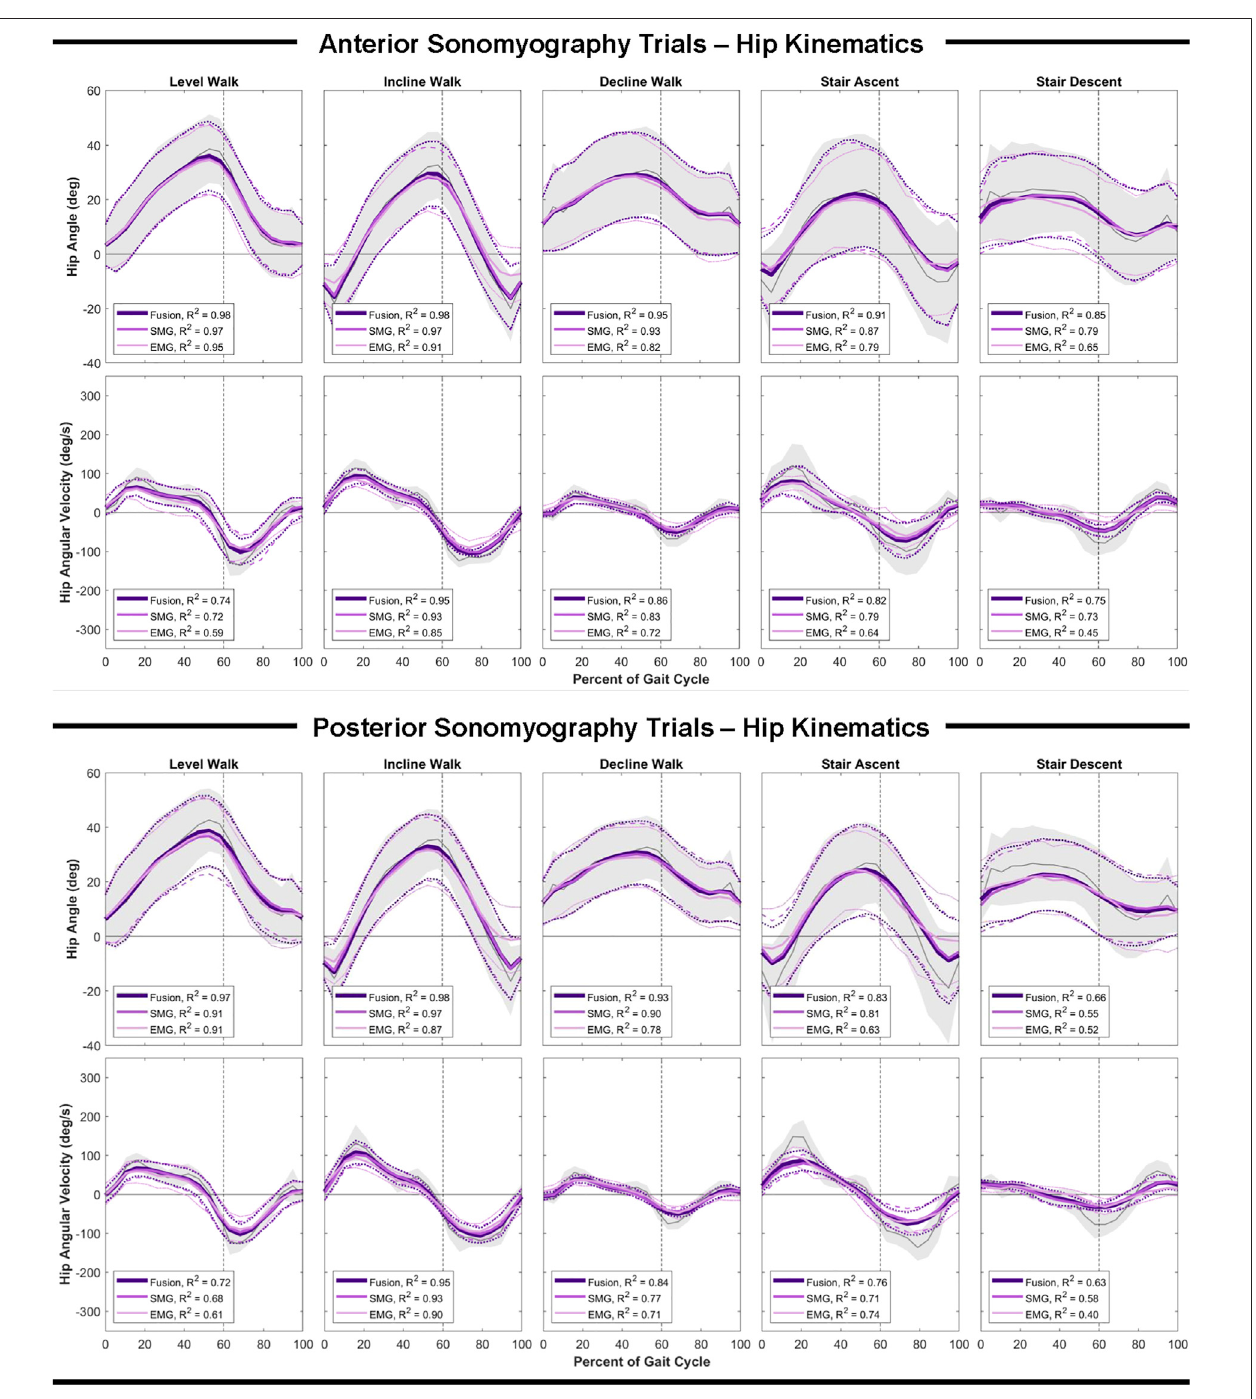
FIGURE 4 | Hip angle and angular velocity as a function of the gait cycle. Measured kinematics are displayed in gray with standard deviations in shaded regions. PredictedkinematicsfromGaussianprocessregressionmodelstrainedandtestedonfeaturesfromelectromyography(EMG),sonomyography(SMG)andsensorfusion (Fusion) are displayed with respective standard deviations. Adjusted R 2 given as a goodness-of- fi t metric for each sensing modality compared to the measured kinematics.